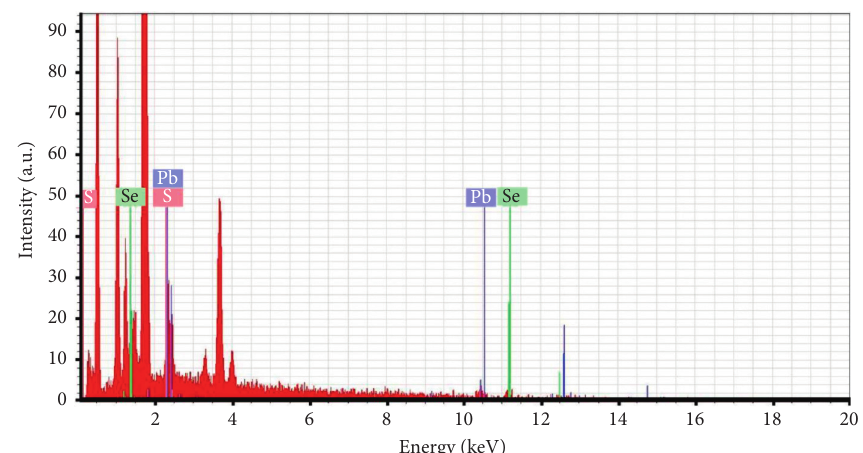
Figure 6: EDAX spectrum of thin films deposited from [Pb((SeP i Pr